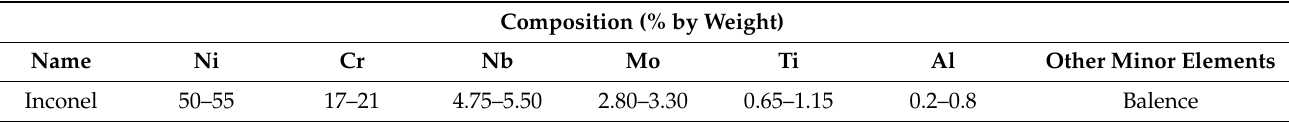
Table 2. Composition (% by weight) of Inconel 718 used as a substrate.